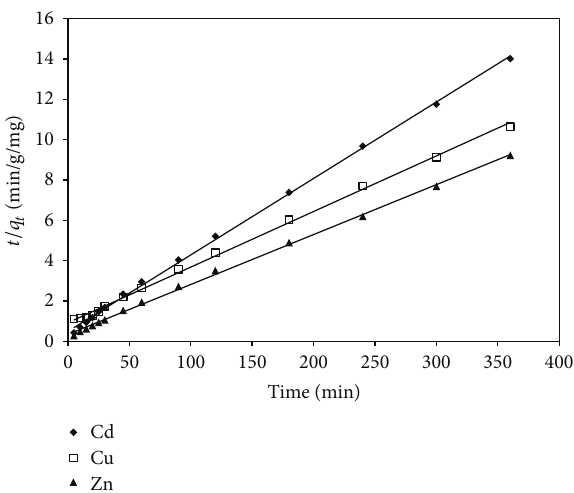
Figure 7: Pseudo second-order kinetic model in the adsorption of Cd (II), Cu (II), and Zn (II) onto Aminated Desmostachya bipinnata